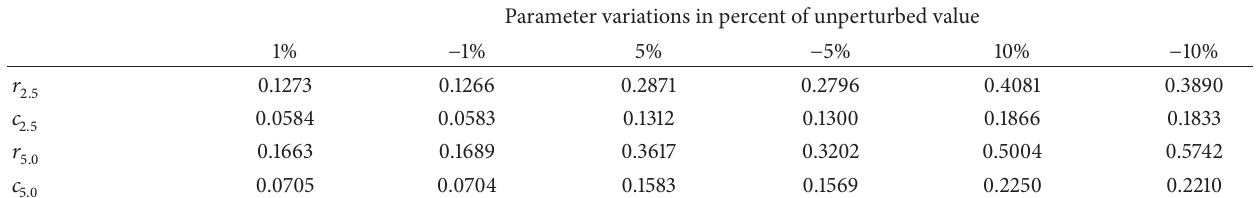
Table 1: Relative errors in energy norm (subscript at parameters denotes the nondimensional time unit).